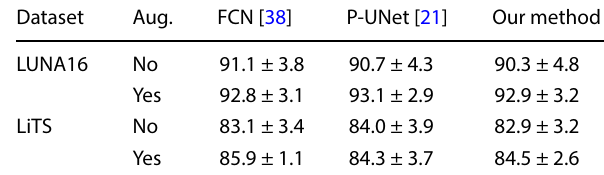
Table 2 Dice scores (%) accumulated with three methods in differ- ent network frameworks with and without data augmentation Dataset Aug. FCN [38] P-UNet